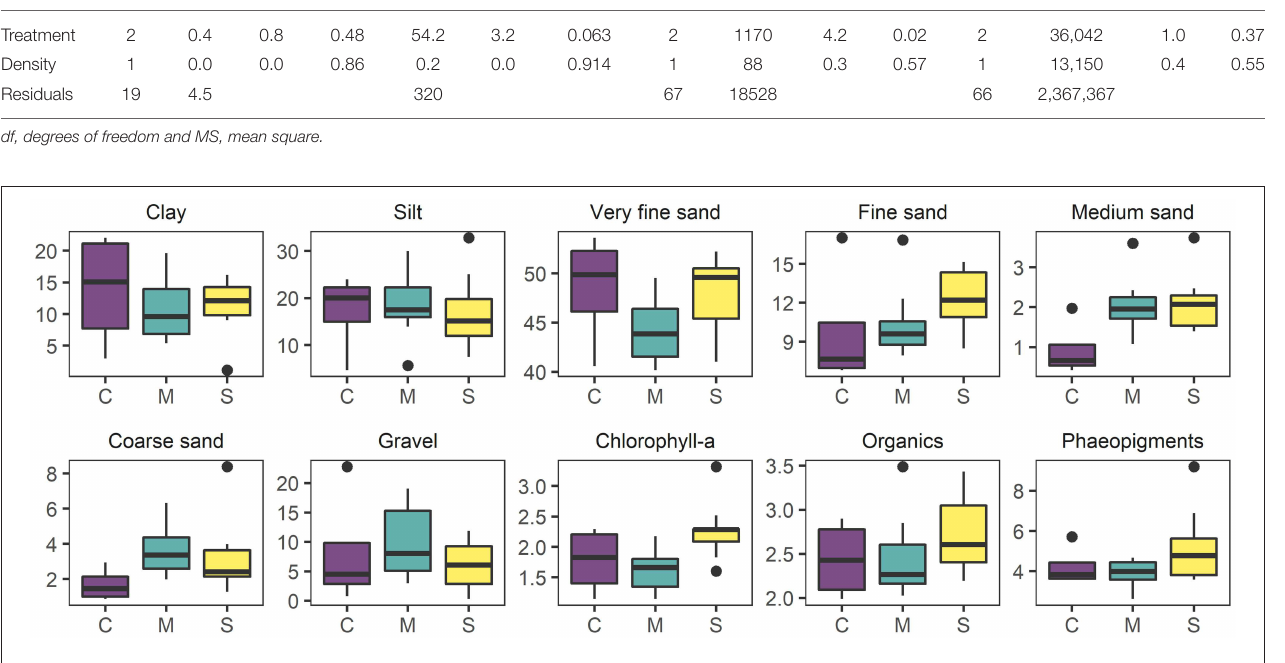
FIGURE 6 | Boxplots of soft sediment physico-chemical environmental variables: clay ( < 0.98 µ m), Silt (3.9–62.5 µ m), very fine sand (62.5–125 µ m), fine sand (12–250 µ m), medium sand (0.28–0.5mm), coarse sand (0.5–1.0mm), gravel ( > 1mm), chlorophyll- a ( µ g g − 1 ), organic content (% LOI), and phaeopigments ( µ g g − 1 ) in relation to experimental treatments: C, “Control”; M, “Mimic”; S, “ Sabella ”.